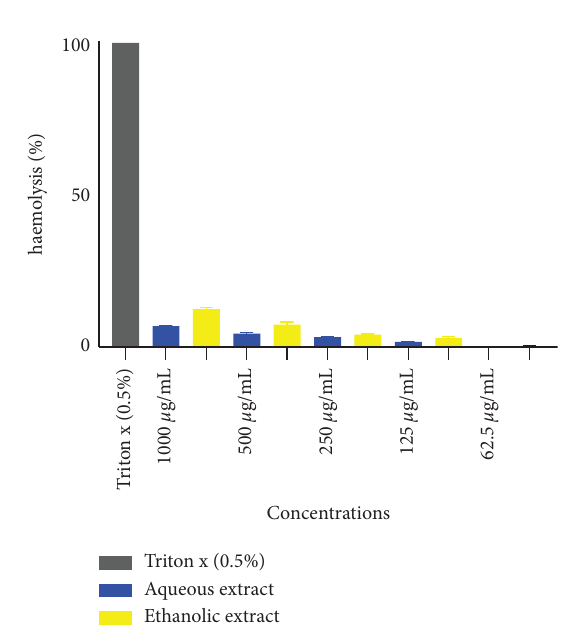
Figure 1: Efect of L. lanceolata on haemolysis. Table 2: Efect of L. lanceolata on RAW 264.7 cells.